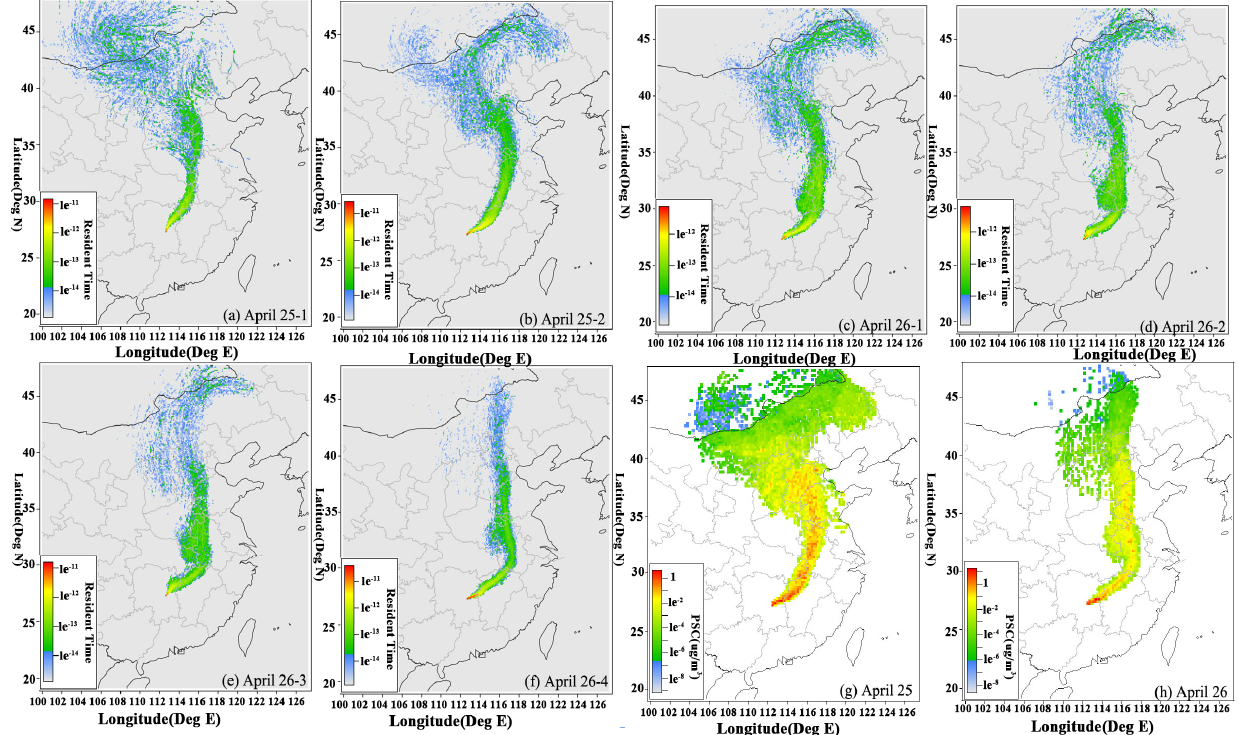
Figure 6. Illustrations of three-day backward retroplumes and potential source contributions (PSCs) during the sandstorm. ( a – f ) Map of the “footprint” ( i.e. , 100 m) retroplume (residence time) and ( g – h ) maps of the PSCs of PM 2.5 (PAHs) at Mount